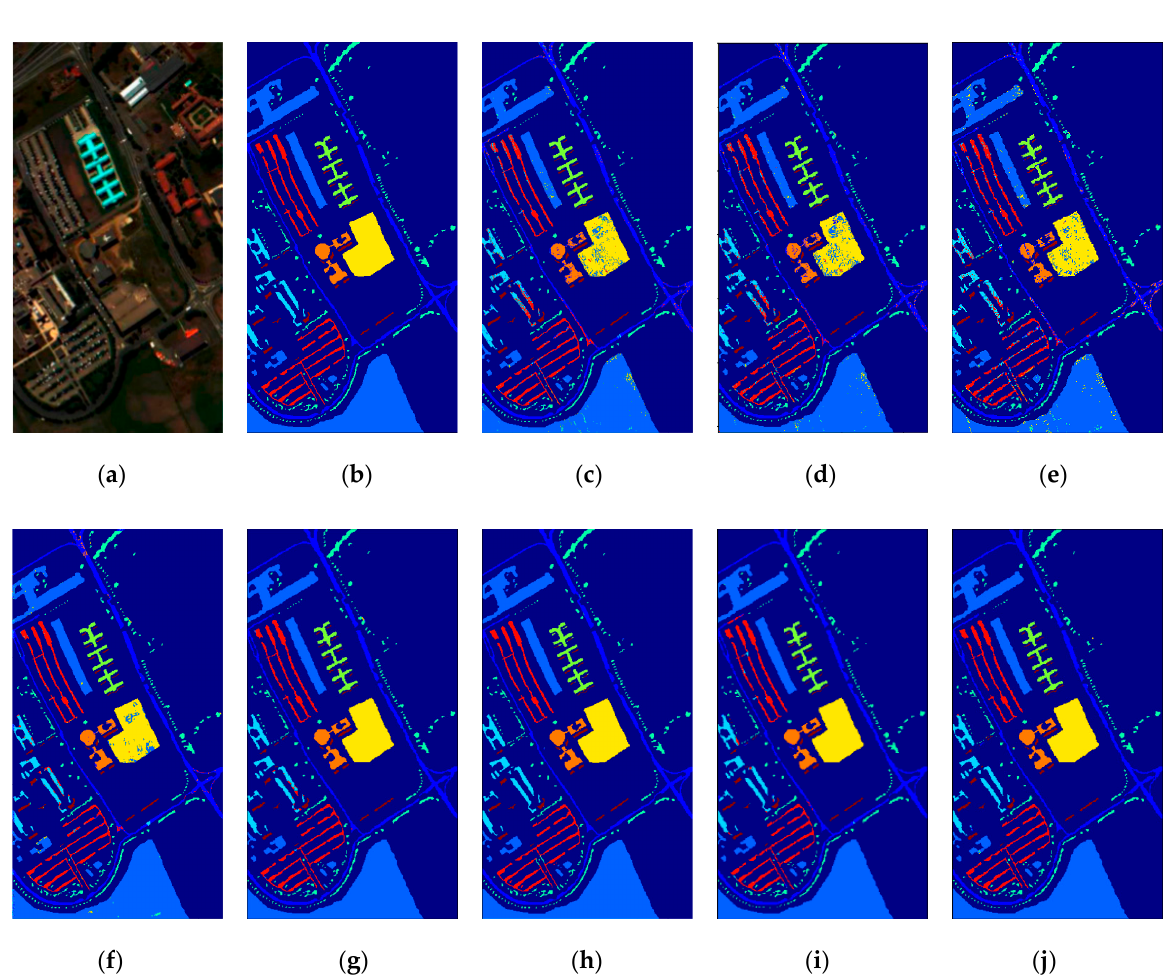
Figure 10. Classification maps for the Pavia University dataset. ( a ) False-color image. ( b ) Ground truth. ( c ) SVM. ( d ) PCA. ( e ) LSTM. ( f ) 3DCNN. ( g ) SSRN. ( h ) DFFN. ( i ) MSCNN. ( j ) SSDF.